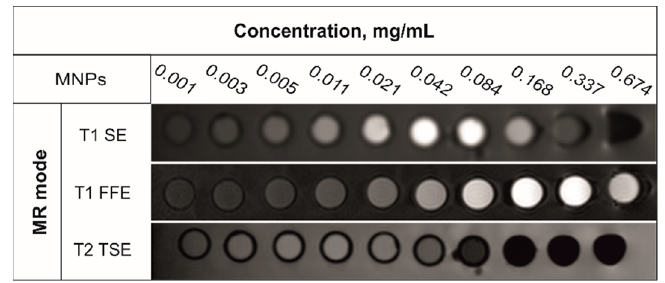
Figure 5. MRI images of magnetite nanoparticle colloid.